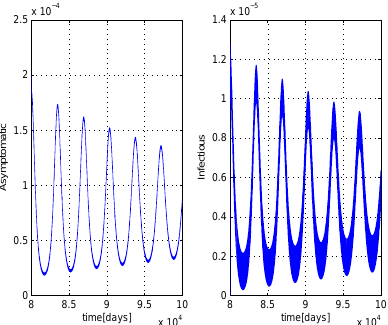
Fig. 4: The inclusion of A and Q can support sustained oscillations, γ = γ 1 /γ ∈ (3 , 7) , (cid:60) σ = 0 . 2